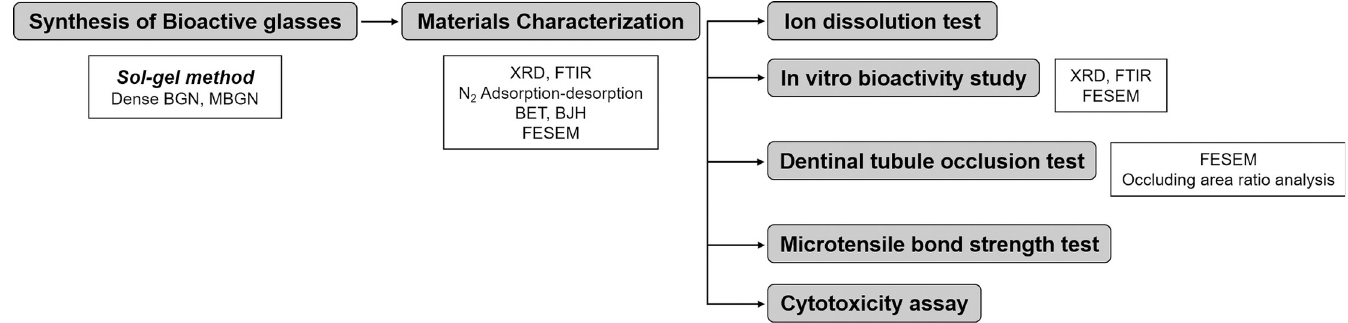
Fig 1. A schematic diagram of materials and method.